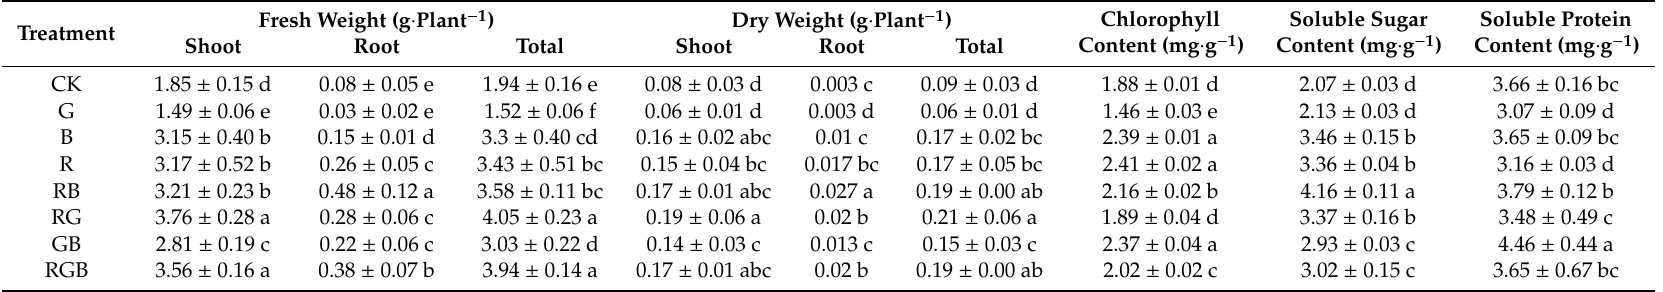
Table 1. E ff ects of the di ff erent supplemental lighting treatments on biomass of shoot and root, physiological parameters of cucumber seedlings under extremely low